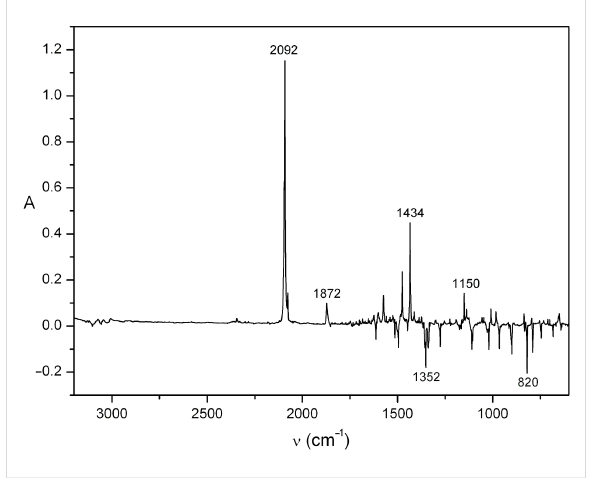
Figure 1: Difference-IR spectrum of 2-diazomethylpyrazine ( 22 ) (positive peaks) in Ar matrix at 7 K, obtained by photolysis of triazolo- pyrazine 24 at 290 nm for 10 min (negative peaks). Spectrum assigned to 22 : 795, 835, 918, 1009, 1056, 1150, 1299, 1434, 1476, 1574, 2076 and 2092 cm − 1 ; the latter two absorptions are assigned to the two s- E and s- Z conformations of the diazo group. The peak at 1872 cm − 1 is due to the formation of a small amount of the photoproduct 20 . See the Supporting Information File 1, Figure S1 for a full spectrum of 24 with peak